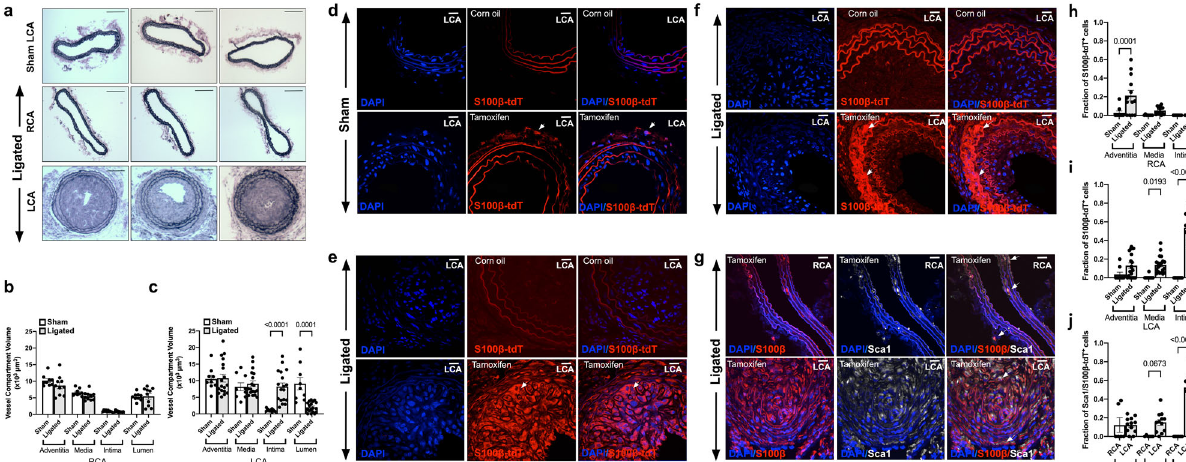
Fig. 3 Lineage tracing analysis of S100 β -Cre(ERT2)-tdT marked cells following iatrogenic fl ow restriction for 21 days. a – c Verhoeff-Van Gieson stained sections and morphometric analysis of adventitial, medial, intimal and luminal volumes of the b contralateral RCA control compared to the c LCA following ligation for 21d. Data are the mean ± SEM of 10 images, # p < 0.05 vs sham controls. d – f Representative confocal fl uorescence images of DAPI nuclei (blue) and S100 β -tdT (red) cells in mice treated with corn oil (control) or tamoxifen for 7 days prior to washout for 1 week in d sham and e, f ligated LCA. Data are minimum of four animals per experimental group. Scale bar = 20 µm. Arrows highlight S100 β -tdT (red) marked cells. g Representative confocal fl uorescence images of DAPI nuclei (blue), immuno fl uorescence of anti-tdT (red) and anti-Sca1 (far red, white) expression in the contralateral RCA and LCA 21 days post-ligation. Scale bar = 20 µm. h – j Cumulative analysis of the fraction of S100 β -tdT + cells in the h RCA and i LCA and j Sca1/S100 β double stained cells in the adventitial, medial and intimal layer of RCA and LCA vessels, respectively, after 21 days in S100 β -CreERT2-tdT